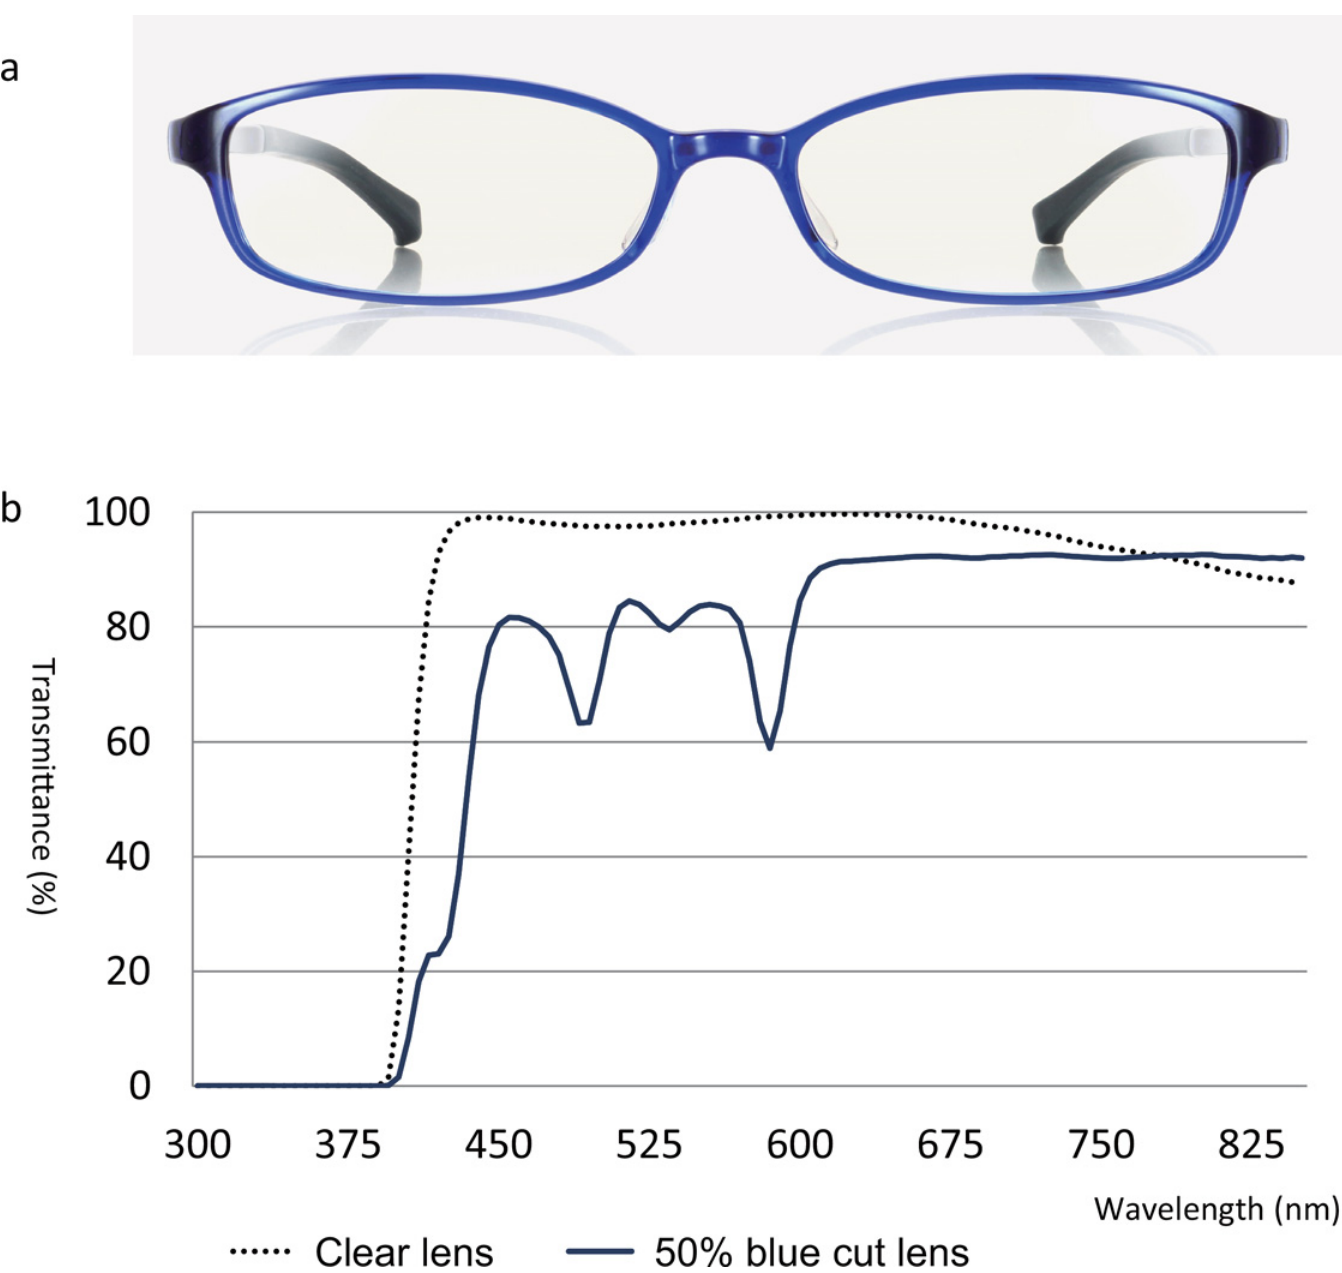
Fig 1. Spectacles with 50% blue light blocked lenses and spectral transmittance curve. a: Spectacles with 50% blue light blocked lenses. b: Spectral transmittance curve.